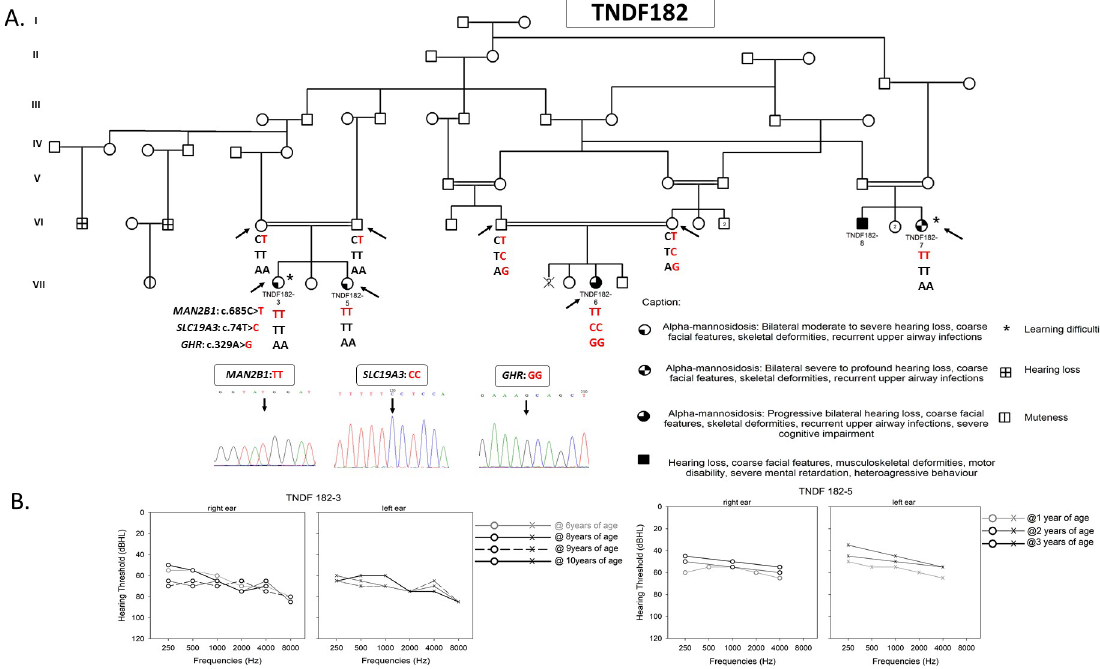
Fig 2. TNDF182 family pedigree and audiometric data from TNDF182-3 and TNDF182-5 patients. The extended TNDF182 family. The arrows indicate the cases for whom the molecular diagnosis was performed. Double lines indicate consanguinity. Red and bold denote the mutant alleles for the three variants identified in MAN2B1 (NM_000528.4), GHR ( � 600946, NM_000163.5), and SLC19A3 ( � 606152, NM_025243.4) genes. Chromatograms of each variant are shown (A). Audiograms of patients TNDF182-3 and TNDF182-5 were obtained using pure-tone audiometry (frequencies from 250 Hz to 8,000 Hz) performed at different ages (B).